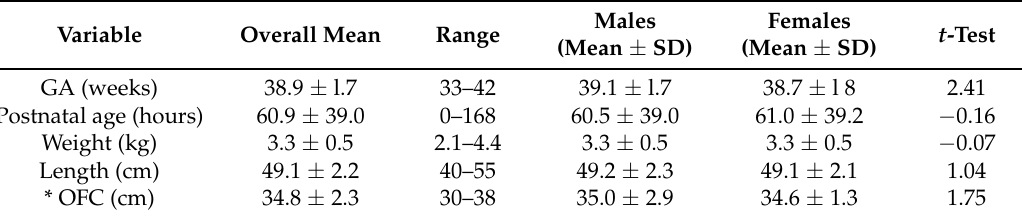
Table 3. Demographic characteristics of the study